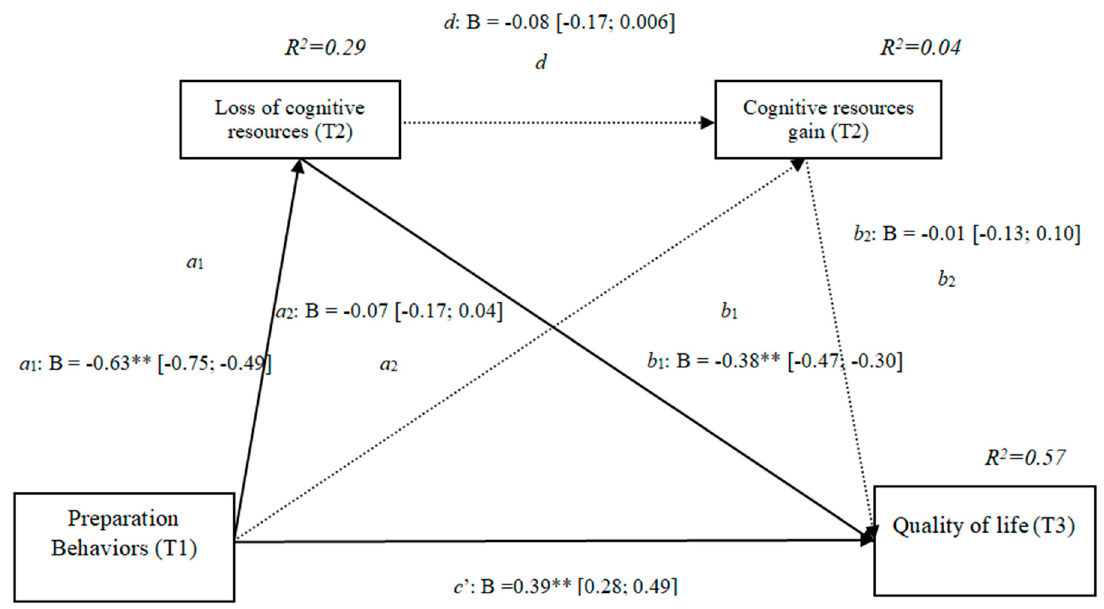
Figure 3. Non-standardized B coefficients, confidence intervals, and statistical significance for cognitive losses and gains. [95% CI]; * p < 0.05; ** p < 0.01.